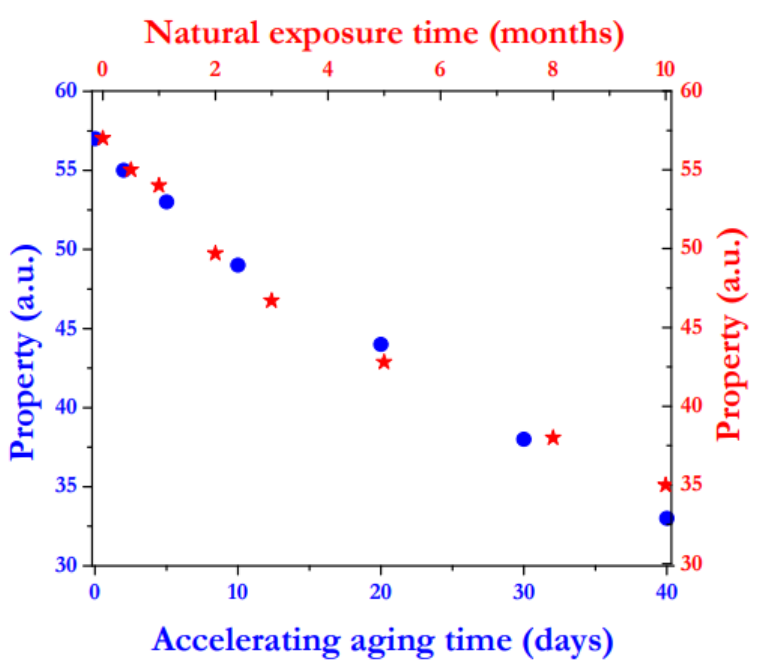
Figure 3. Correlation between the values of an arbitrary property measured on a polymer outdoor exposed and those recorded for the same polymer subjected to an accelerated aging procedure, with the aim to calculate an “Equivalent time”.